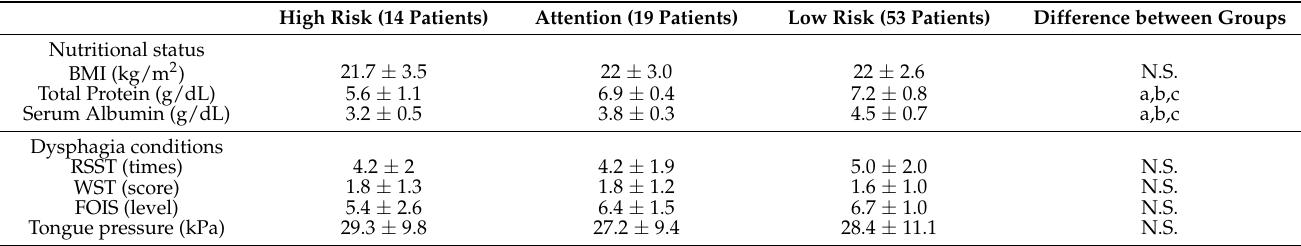
Table 3. Preoperative patient